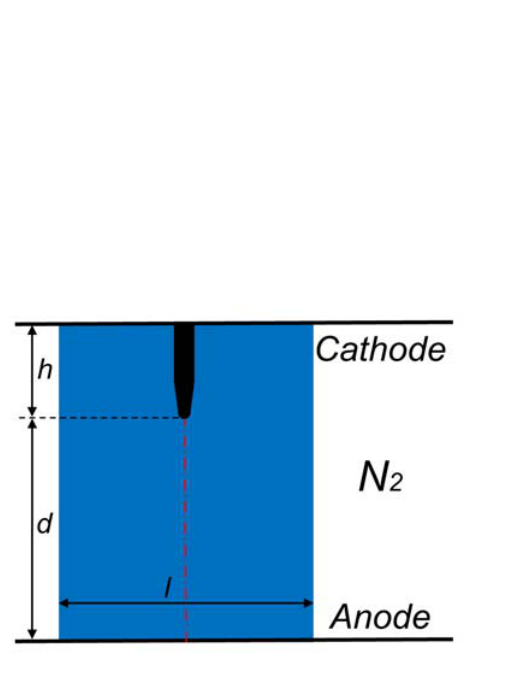
Figure 3 – The computational domain configuration (h = 1.6 mm, l = 4 mm, d = 9 mm) Рис . 3 – Счётная область пространства (h = 1.6 мм , l = 4 мм , d = 9 мм ) Слика 3 – Конфигурација области израчунавања (h = 1,6 mm, l = 4 mm, d = 9